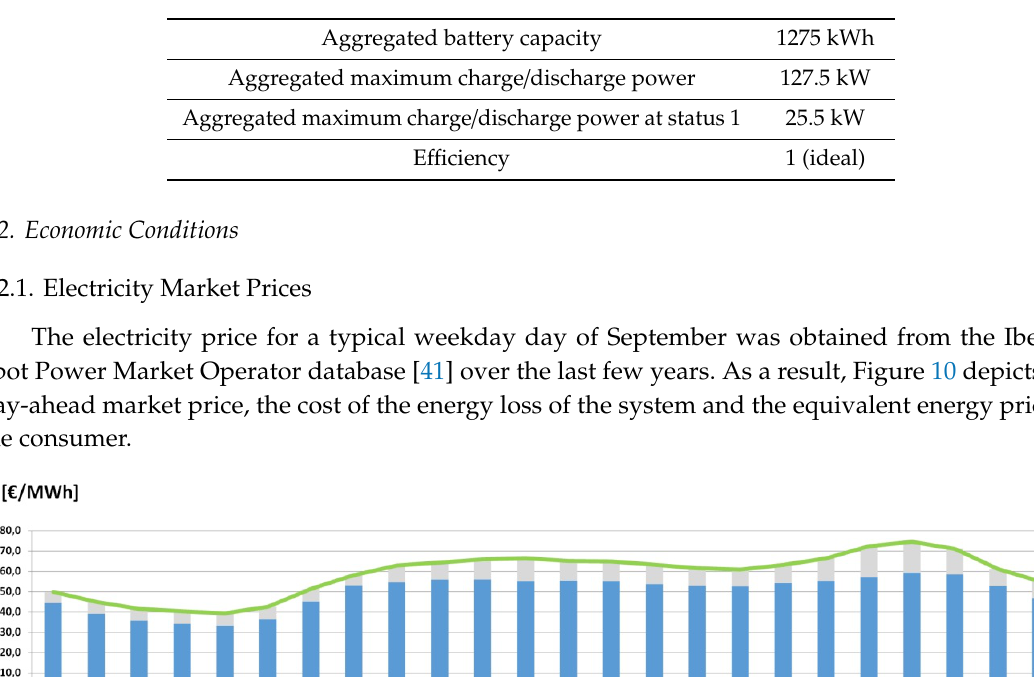
Table 2. Access tariff coefficients [42].